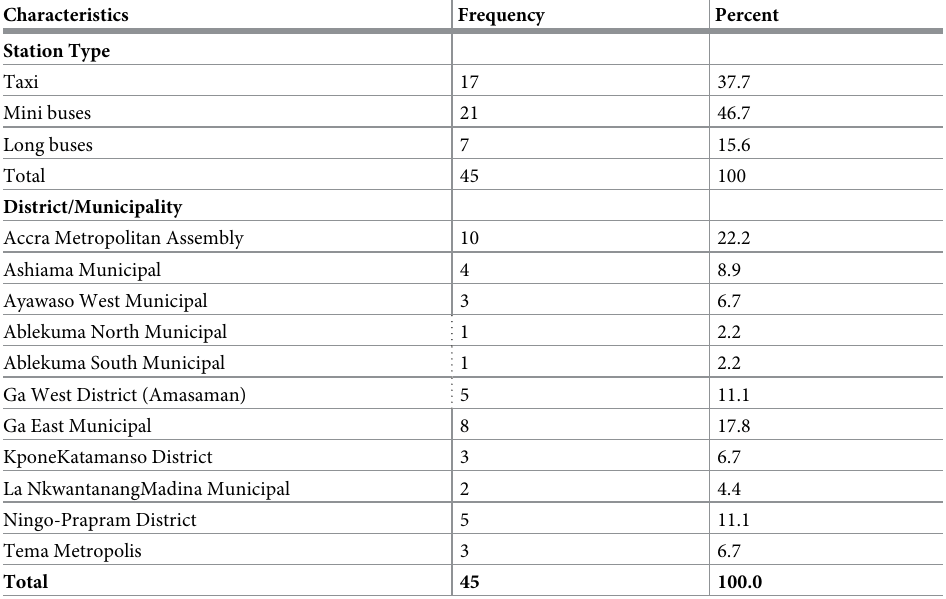
Table 1. Characteristics of public transportation stations (n =